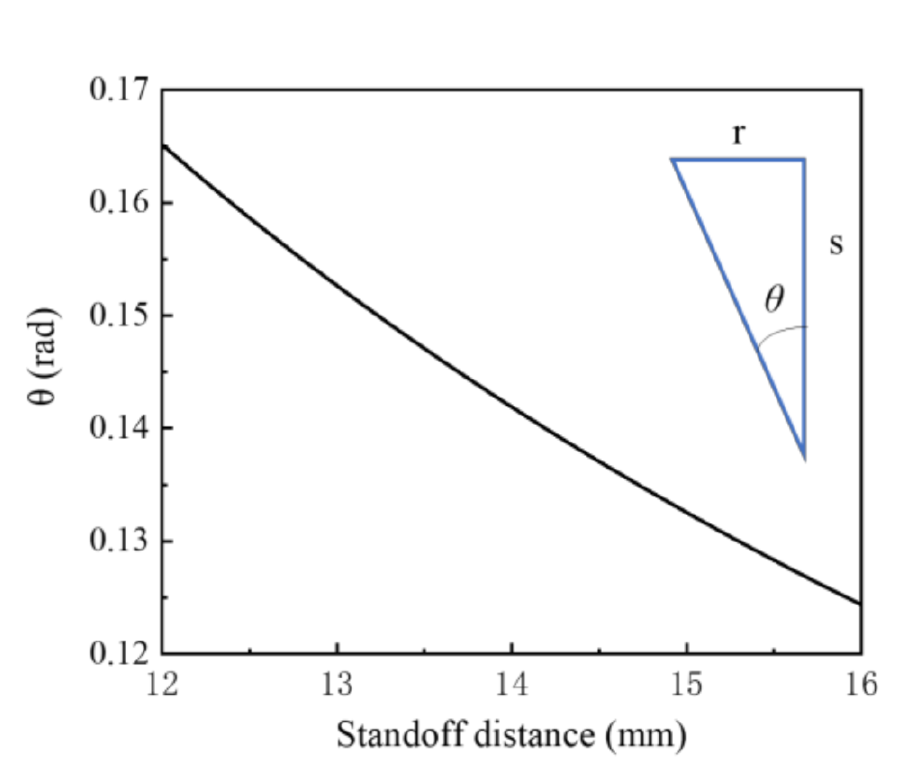
Figure 16. Behaviors of θ as a function of s